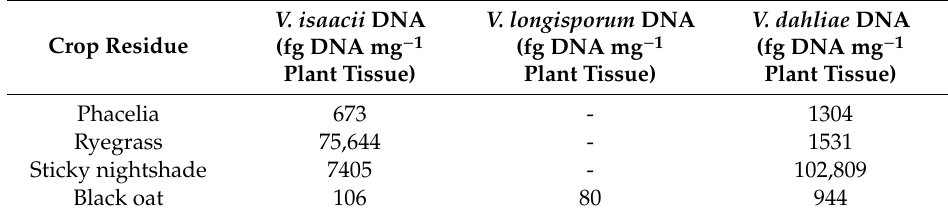
Table 3. Colonization of the green manure residues by Verticillium spp. Green manures were grown for four months in soil naturally infested with V. isaacii, V. longisporum , and V. dahliae , subsequently cut into small pieces (shoot and roots) and put in nylon bags that were buried in the soil for three months. The colonization of these plant residues by the three Verticillium species was quantified via real time-PCR. Samples of three bags were pooled before real time-PCR analysis and values are the detected amounts of Verticillium DNA in these pooled